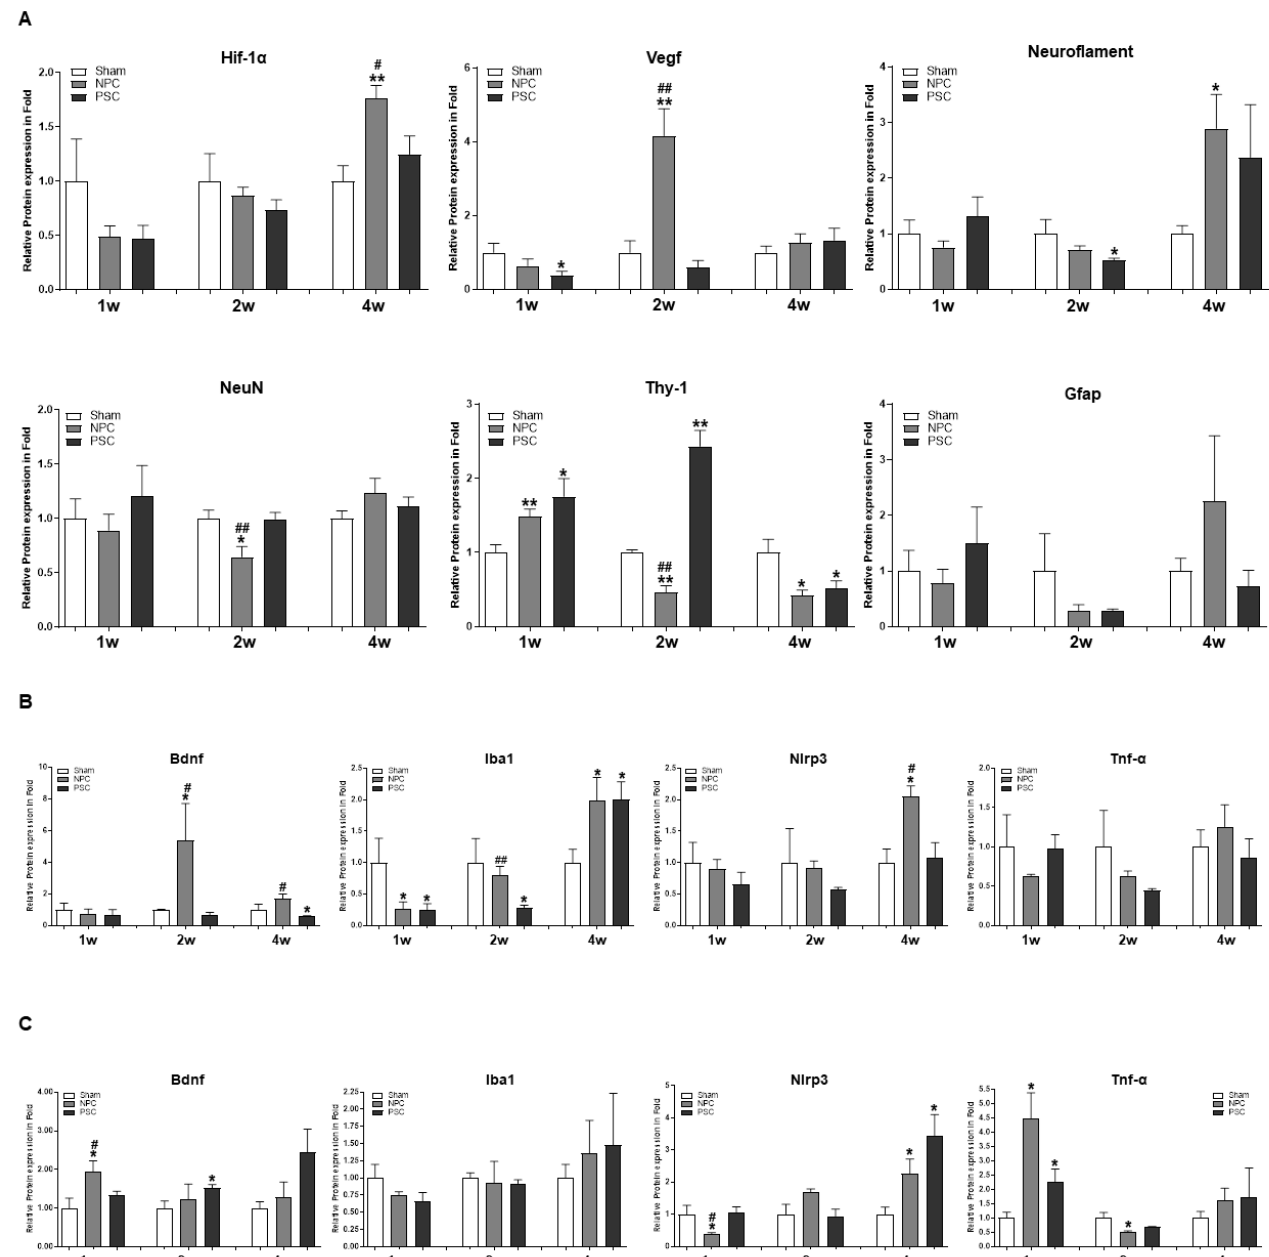
Figure 3. NPCs regulate axonal regeneration and inflammatory proteins in the retina and optic-nerve-injured rat model. Changes in target proteins were assessed by immunoblot analyses of rat retina and optic nerve extracts. The samples were analyzed 1, 2, and 4 weeks after injection with optic nerve compression. Expression levels were normalized to β -actin and the values of OS were divided OD. ( A ) Quantified values of Hif-1 α , Vegf, Neuroflament, NeuN, Thy-1and Gfap expressions in retina extract are also presented. Quantified values of Bdnf, Iba1, Nlrp3 and Tnf-α expression in ( B ) retina and ( C ) optic nerve tissues extract are also presented. The results are expressed as the mean ± SEM of independent retina and optic nerve analyses, and are expressed as fold changes compared to the control (* p < 0.05 vs. the age-matched sham (balanced salt solution): # p < 0.05; ## p < 0.01 vs. PSCs). OD, oculus dexter; OS, oculus sinister.